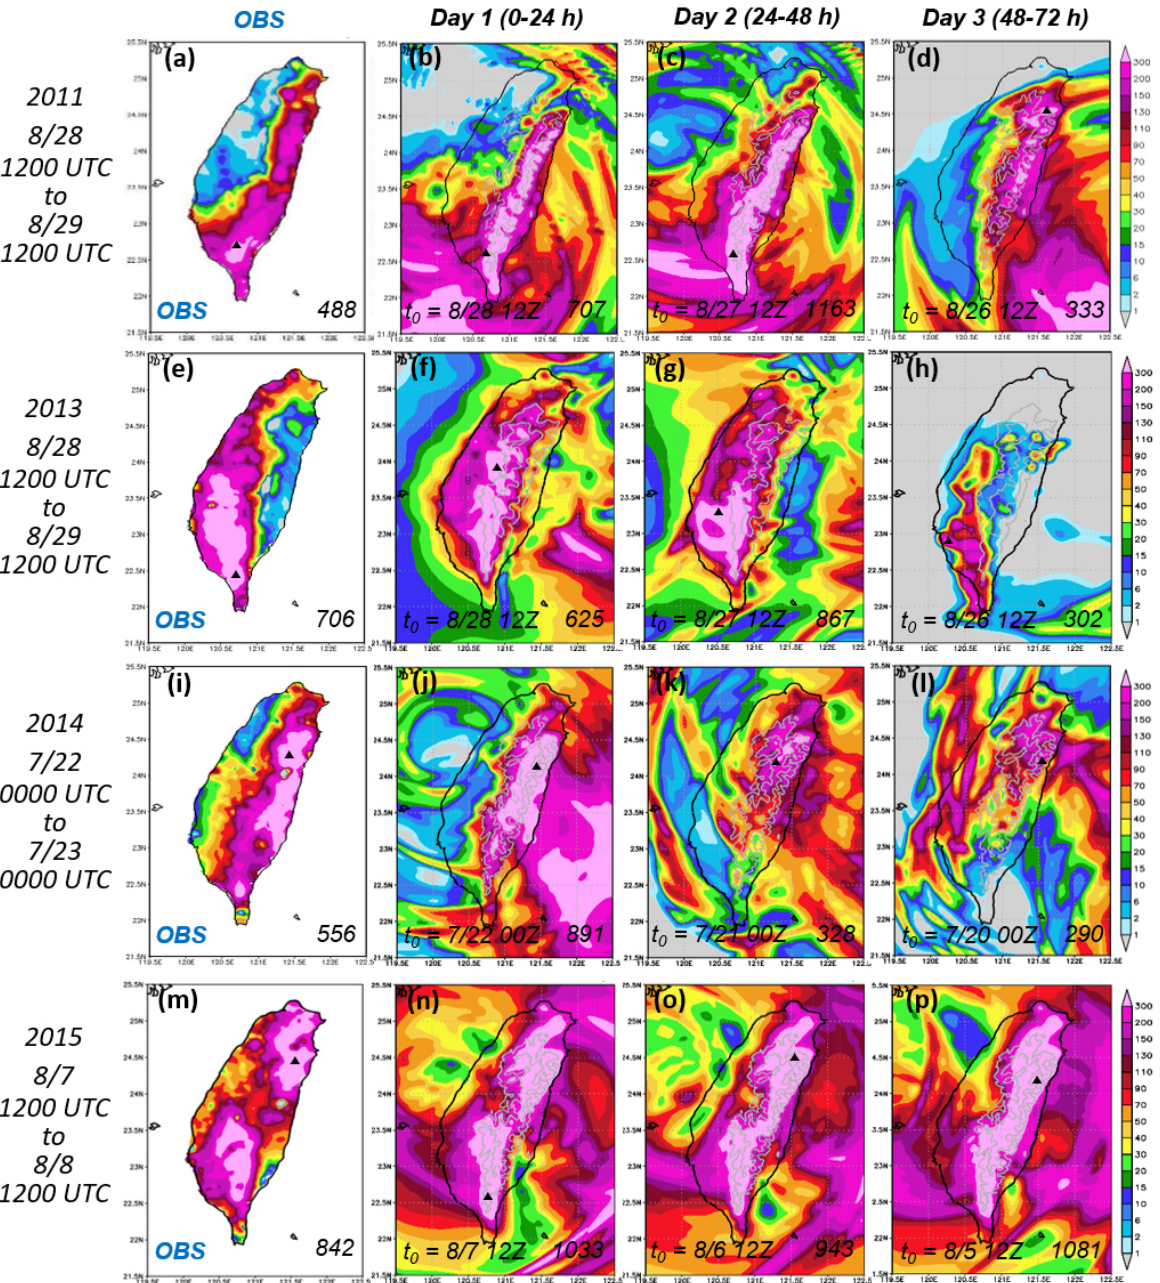
Figure 11. As in Figure 7, except for the rainfall distribution (mm) in observation and CReSS QPFs at ranges of days 1–3, valid for the 24 h period starting from ( a – d ) 1200 UTC 28 August 2011 during TY Nanmadol, ( e – h ) 1200 UTC 28 August 2013 during TY Kong-Rey, ( i – l ) 0000 UTC 22 July 2014 during TY Matmo, and ( m – p ) 1200 UTC 7 August 2015 during TY Soudelor,